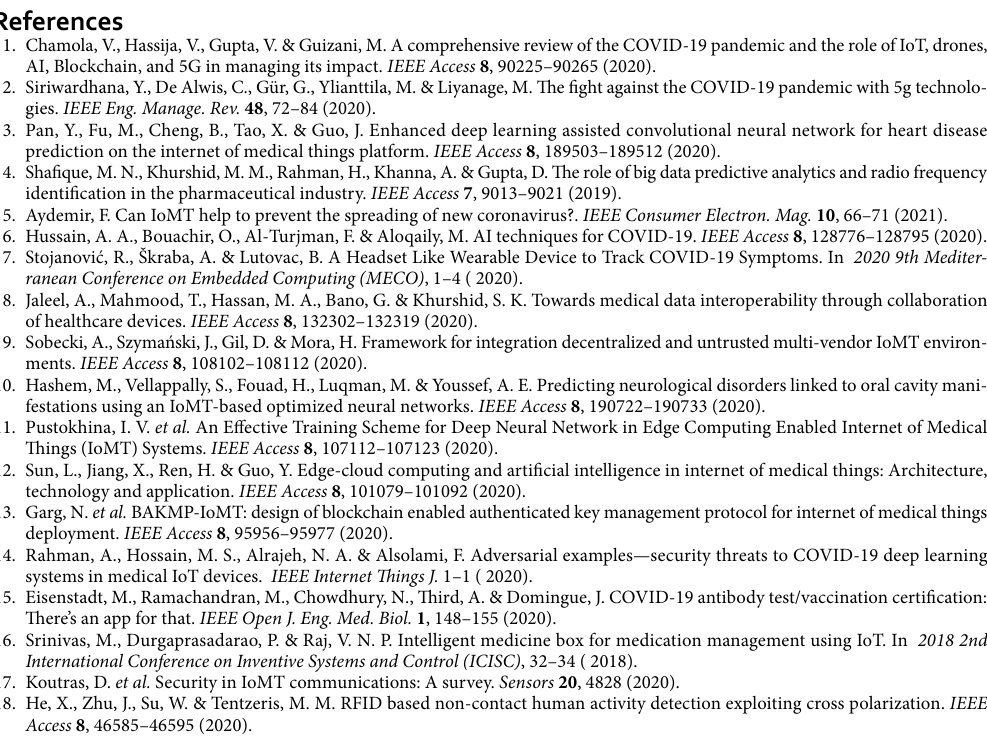
Table 2. Color-holding performances (color retention time) of the color-change RFID tag using the Q/GHSC 1571–2009, phenolphthalein and anthocyanin pH-indicating paper.